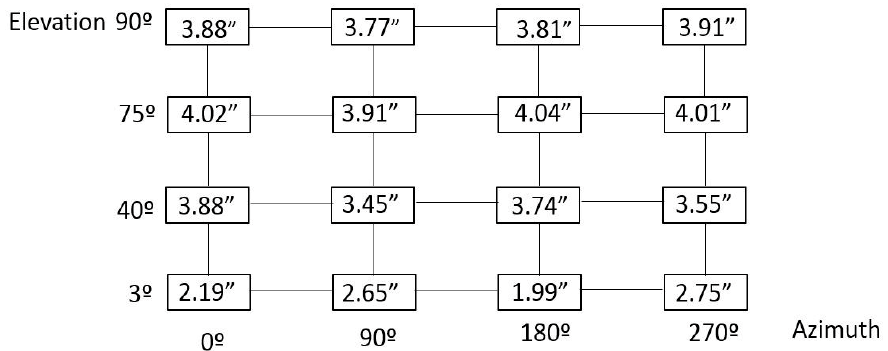
Figure 8. RPE measurement uncertainty results with floor movement consideration (in arcseconds).